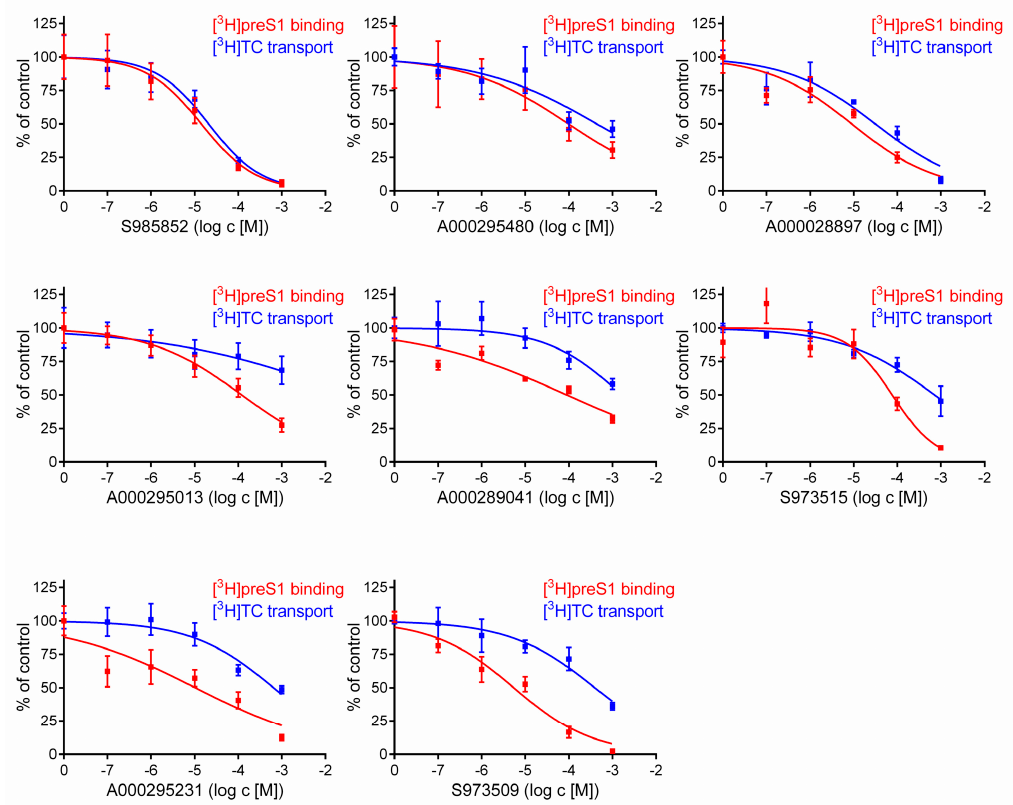
Figure 3. Inhibition of [ 3 H]preS1 peptide binding to NTCP and [ 3 H]TC transport via NTCP at increasing concentrations of propanolamine derivatives. NTCP-HEK293 cells were seeded onto 96-well plates and were incubated with tetracycline to induce expression of NTCP. Cells without tetracycline treatment were used as 0% controls for both assays. Bile acid transport experiments were performed with 1 μ M [ 3 H]TC and binding experiments were performed with 5 nM [ 3 H]preS1. Both assays were performed over 10 min at 37 °C with increasing concentrations of the indicated inhibitors. Control experiments were performed with solvent alone (set to 100%). The mean of the 0% control was subtracted to calculate net [ 3 H]TC transport rates (shown in blue) as well as net [ 3 H]preS1 binding rates (shown in red), which are expressed as % of control at the y -axis. Half-maximal inhibitory concentrations (IC 50 ) were calculated by nonlinear regression analysis using the equation log(inhibitor) vs. response (GraphPad Prism). Data represent means ± SD of quadruplicate determinations of representative experiments.